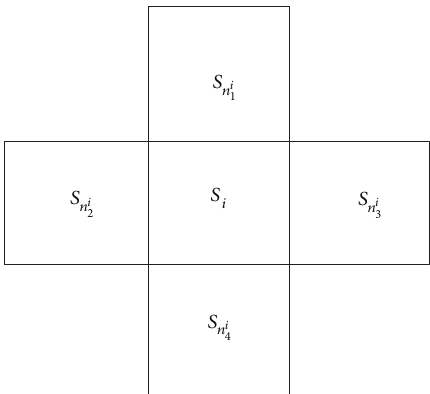
Figure 1: Von Neumann neighborhood where each cell has four nearest neighbors.